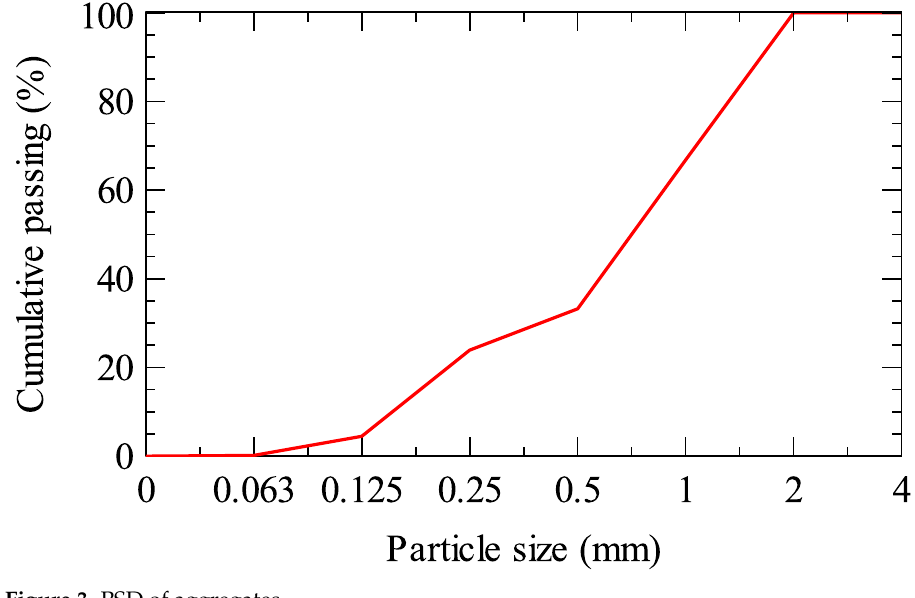
Figure 3. PSD of